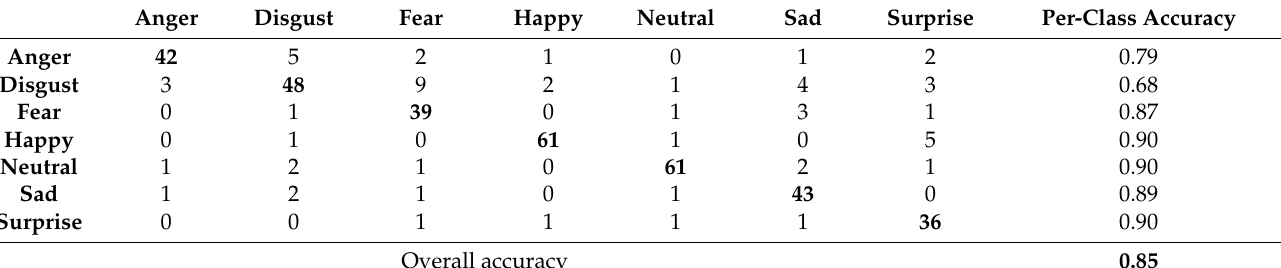
Table 6. Cross-validation over the KDEF